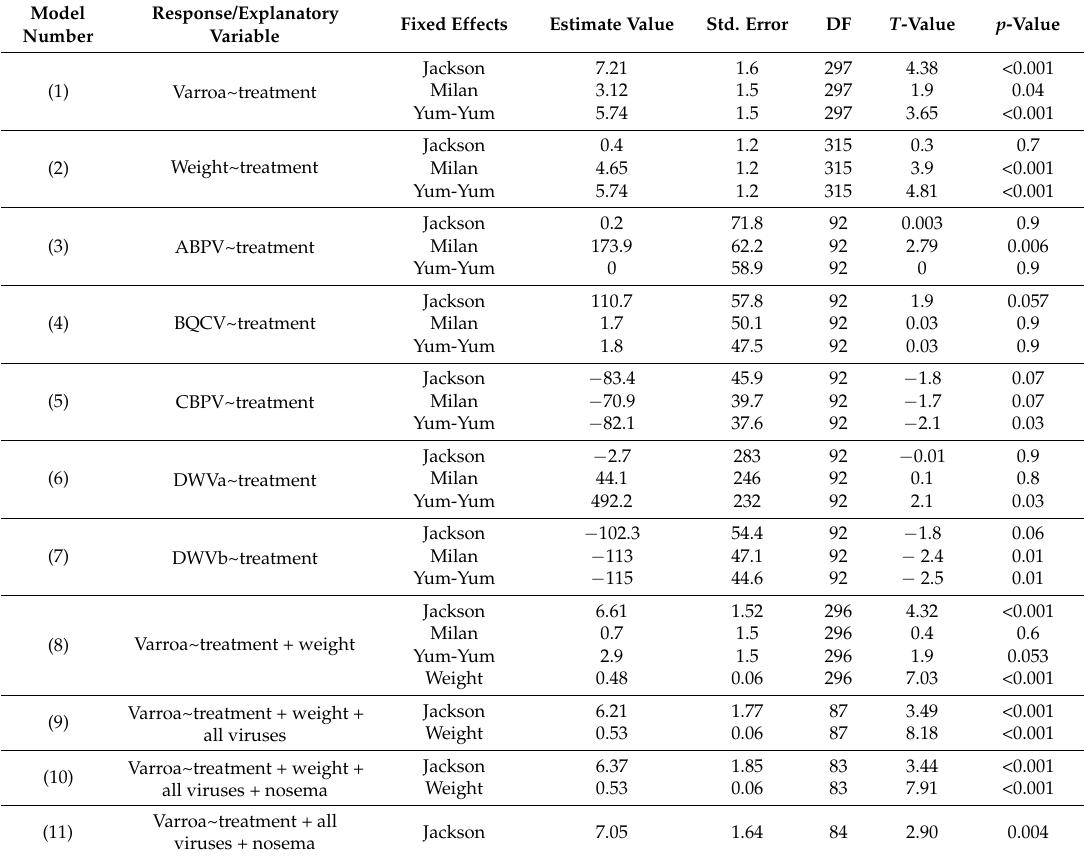
Table 2. Output results of the generalized linear mixed-effects analyses conducted on the dataset. Only significant results were reported in this table. Respond and explanatory variables as well as the fixed effects used in each model are also reported. In all GLMMs, one random effect was considered; agricultural area (AG area). In last three models, only significant fixed effects are provided. For full GLM outputs, refer to the DOI link in the supplementary